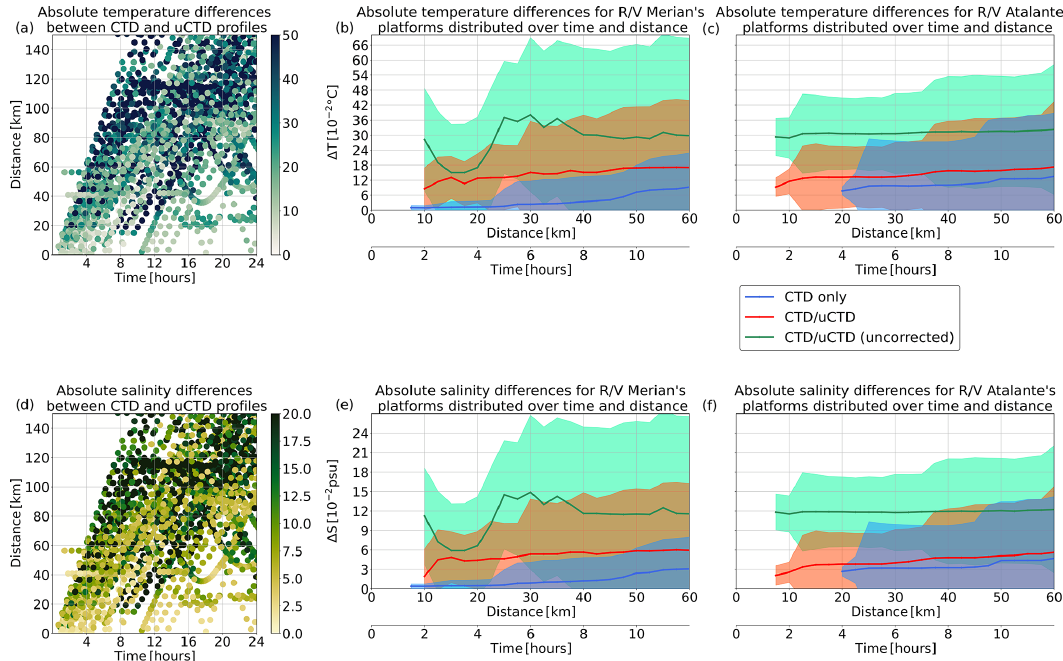
Figure 11. (a) Absolute temperature differences between CTD/uCTD pairs of profiles on isopycnal levels and averaged vertically distributed in time and distance. Each pair is composed of profiles from the same R/V (one CTD and one uCTD). (b) Temperature differences as a function of time and distance for pairs of profiles from R/V Maria S. Merian . The differences are given in blue for pairs of CTD-only profiles, in red for pairs composed of one CTD and one uCTD profile, and in green for pairs composed of one CTD and one uncalibrated uCTD profile. Panel (c) is the same as (b) but for R/V L’Atalante . Panels (d) , (e) , and (f) are the same as above but for absolute salinity